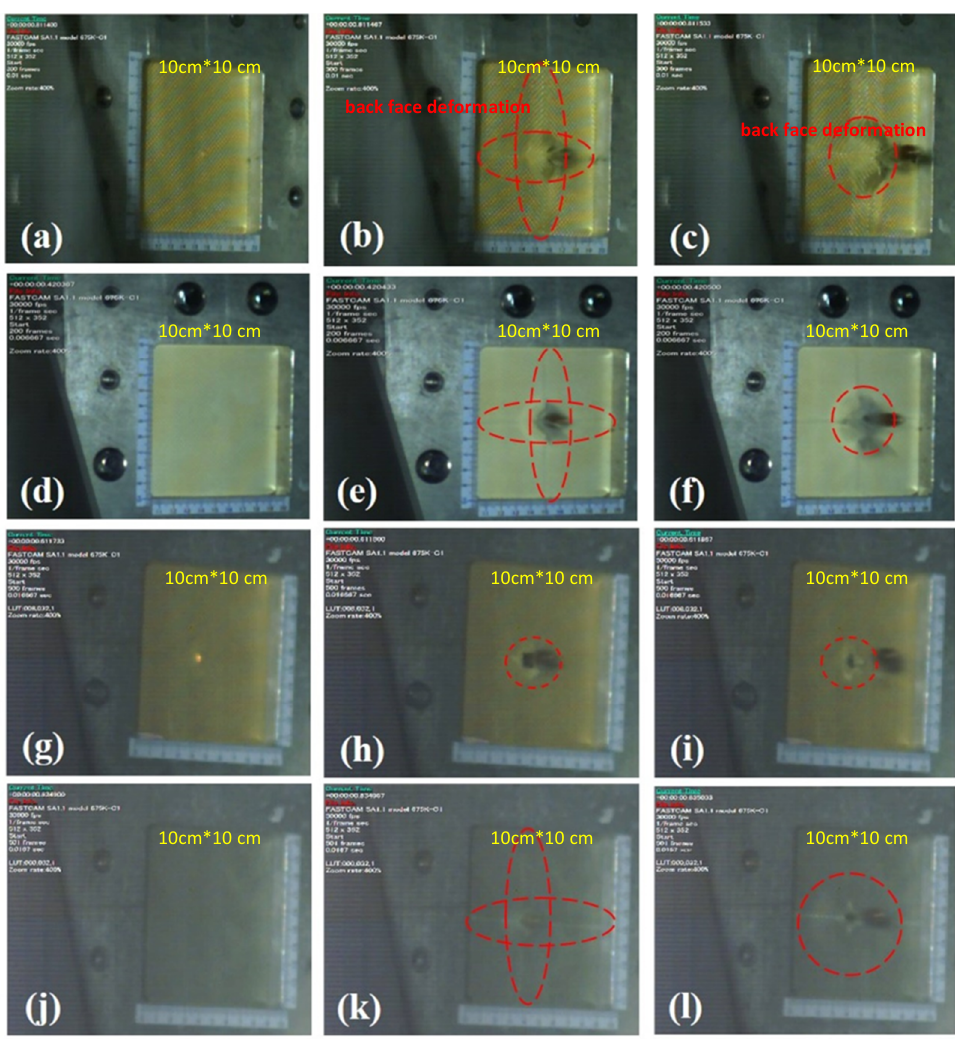
Figure 8. The dynamic back face deformation response of the single-ply ( a ) neat Kevlar plate at t = 0 s; ( b ) neat Kevlar plate at t = 6.7 × 10 −5 s; ( c ) neat Kevlar plate at t = 1.3 × 10 −4 s; ( d ) STF/Kevlar plate at t = 0 s; ( e ) STF/Kevlar plate at t = 6.7 × 10 −5 s; ( f ) STF/Kevlar plate at t = 1.3 × 10 −4 s; ( g ) Epoxy/Kevlar plate at t = 0 s; ( h ) Epoxy/Kevlar plate at t = 6.7 × 10 −5 s; ( i ) Epoxy/Kevlar plate at t = 1.3 × 10 −4 s; ( j ) Polyurea Elastomers/Kevlar plate at t = 0 s; ( k ) Polyurea Elastomers/Kevlar plate at t = 6.7 × 10 −5 s; ( l ) Polyurea Elastomers/Kevlar plate at t = 1.3 × 10 −4 s.